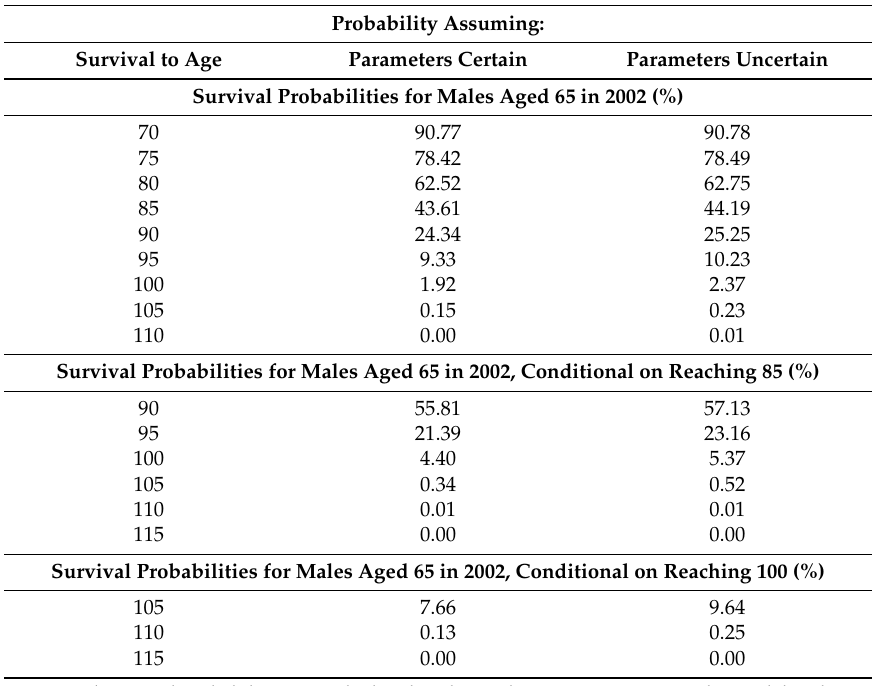
Table 1. Projected Survival